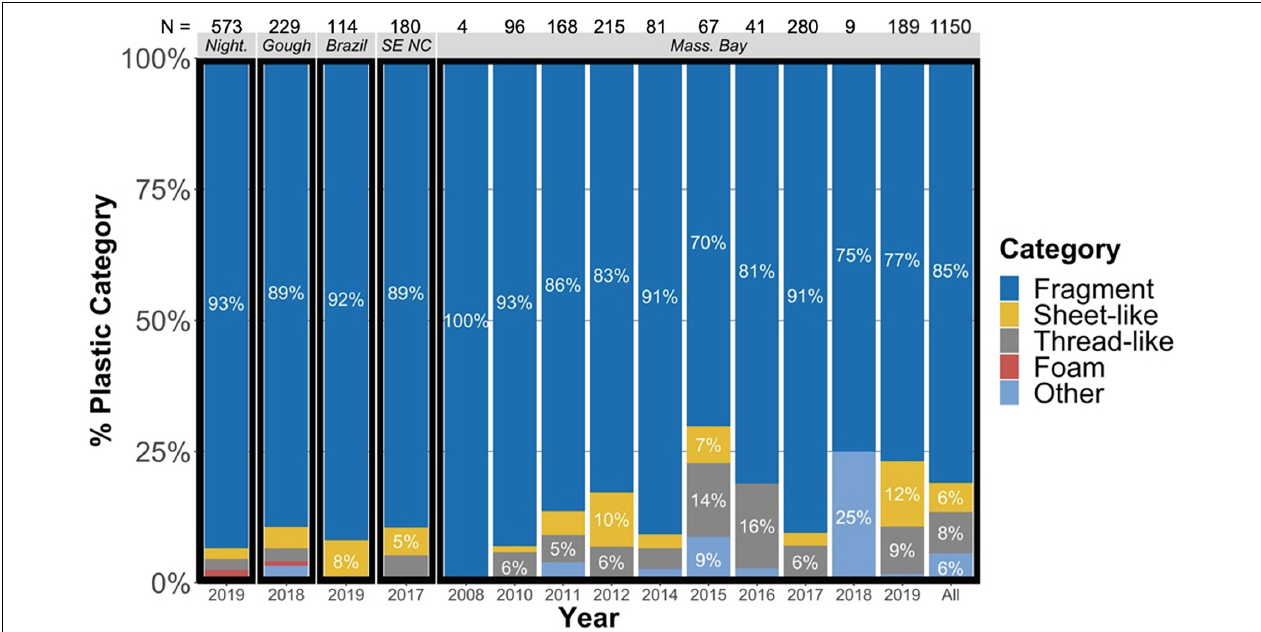
FIGURE 3 | Proportions of each plastic morphology, as a percentage of the total count of plastic items measured within a given year and location. The summary of the Gough Island dataset presented herein omits one clear outlier that possessed 104 plastic pieces of greater category diversity than observed across other mature birds from Gough Island. Night. = Nightingale Island; SE NC = Southeast North Carolina, United States; Mass. Bay = Massachusetts Bay, United States; N = number of plastic items